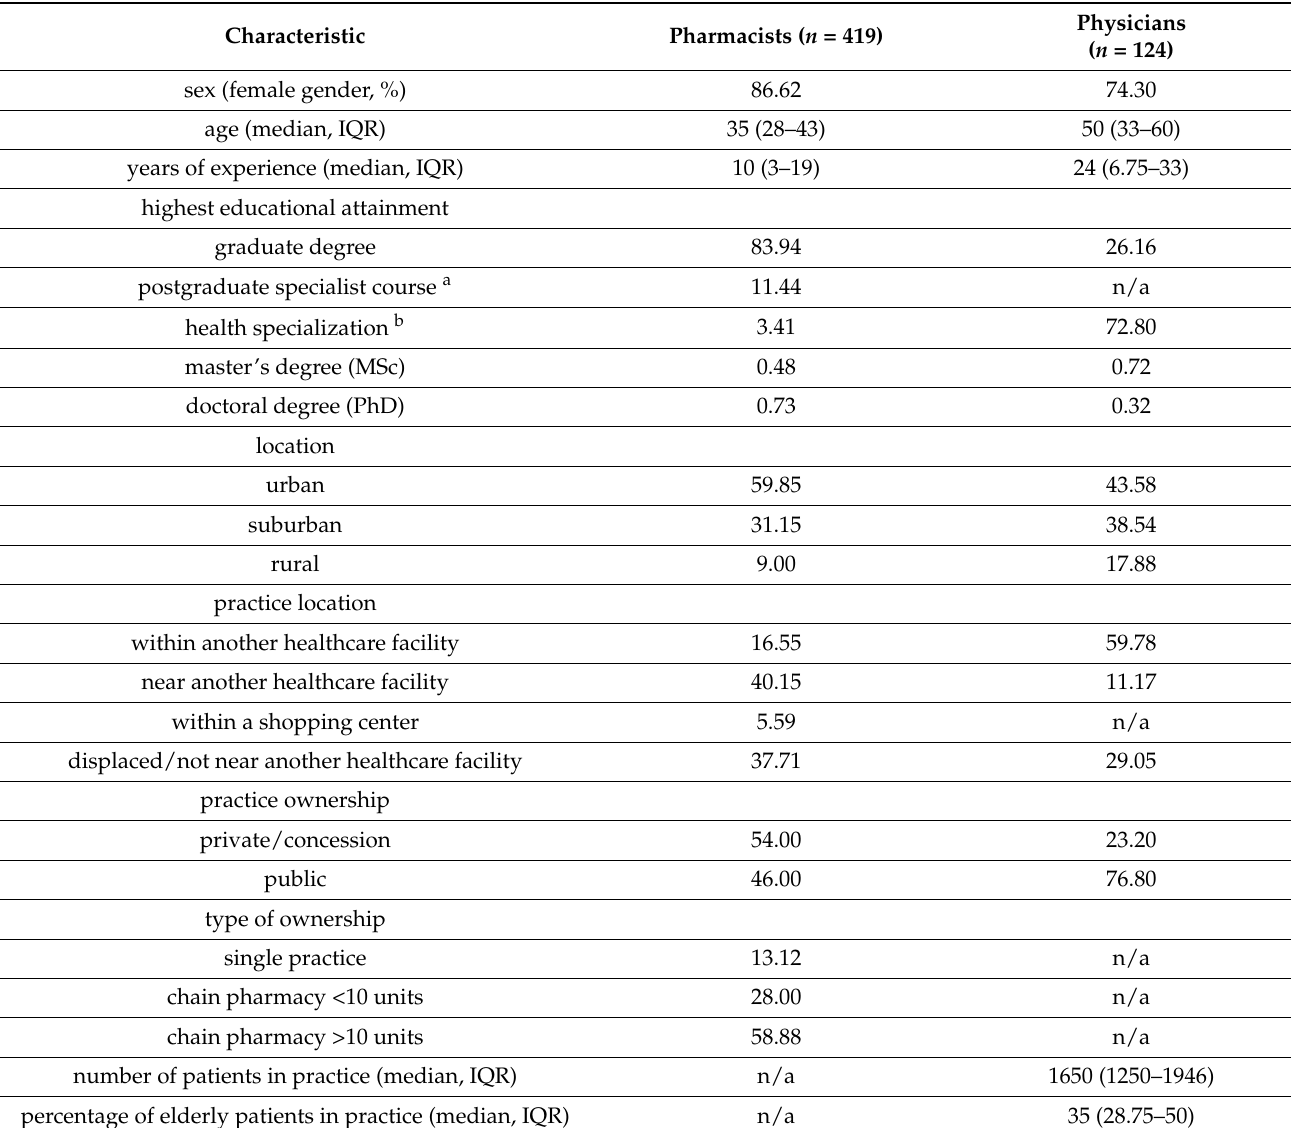
Table 1. Participants’